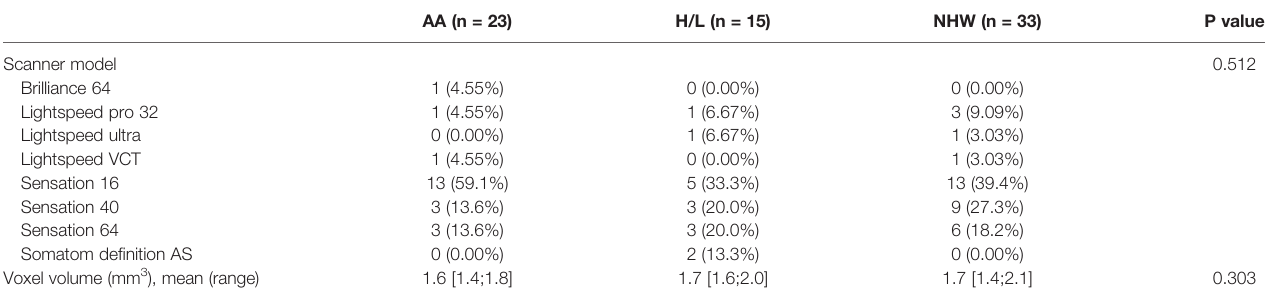
TABLE 2 | Scanner type and voxel volumes measured for the study cohort.